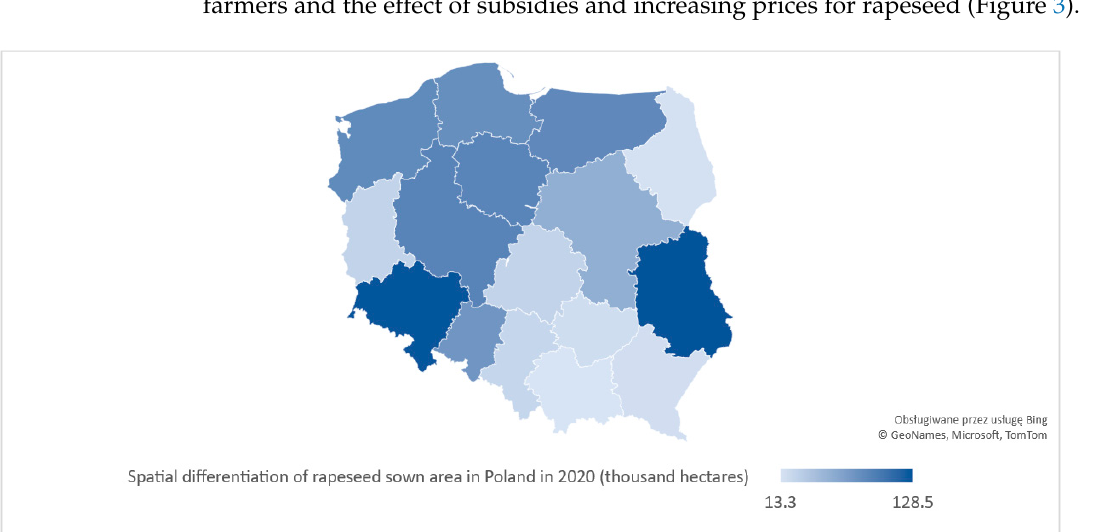
Figure 3. Spatial differences of rapeseed sown area in Poland in 2020 (in thousands of hectares). Source: own elaborations based on the rapeseed market [42].